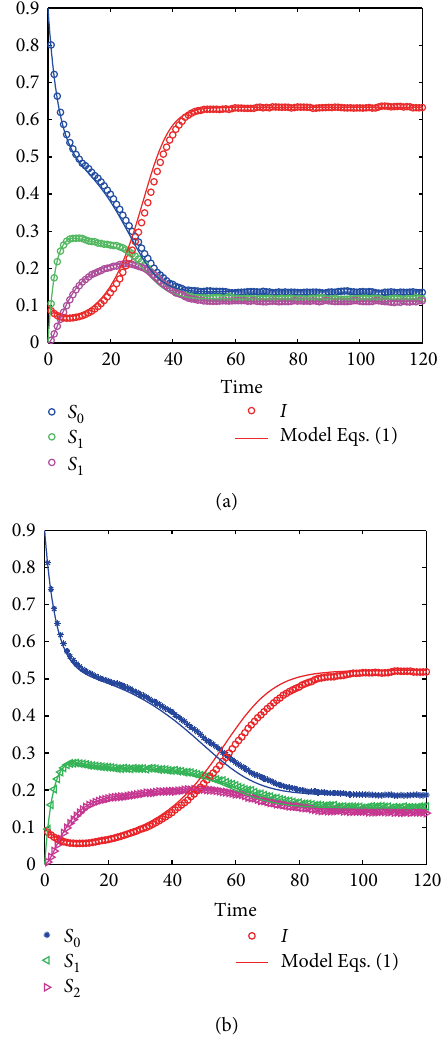
under two different , (b) . 𝑆 𝑆 𝑆 𝐼 𝛽 = 0.15 𝛽 = 0.12